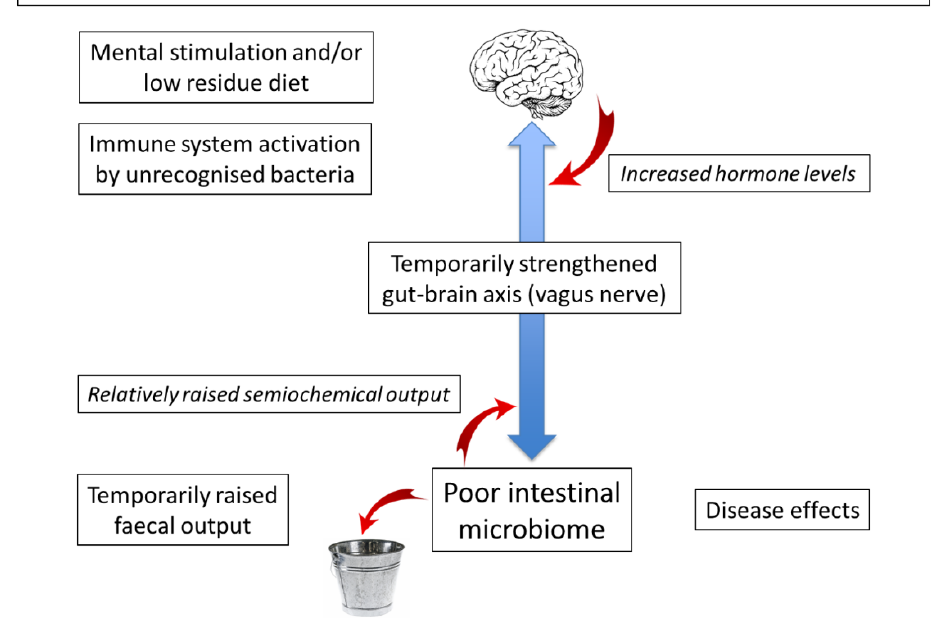
Figure 3. Stimulation of the gut – brain axis (placebo effect). Left hand side: Stimulation of brain, gut, or immune system temporarily strengthens the gut – brain axis, increasing gut motility and allowing more food to pass to the intestine. A rise in semiochemical output is followed by a temporary increase in faecal output. Right hand side: The alert brain may increase hormone levels, while increased semiochemical production may lead to a temporary improvement in physical disease.